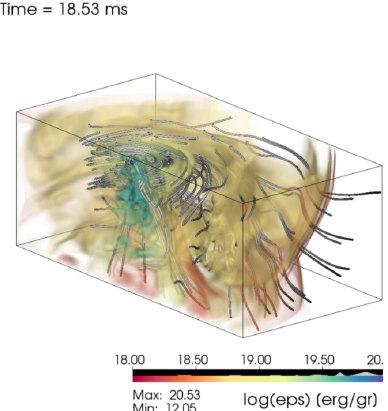
Figure 3. The structure of the torus for a model from [119]. 3D snapshot of the specific internal energy and the magnetic field lines at t = 18.3 ms. Two main points are illustrated in the figure: (i) the structure of the toroidal magnetic field inside the torus; and (ii) the excess of internal energy close to the polar axis where the low density funnel is produced. (Reprinted with permission from [119]. c (cid:13) (2016) by the American Physical